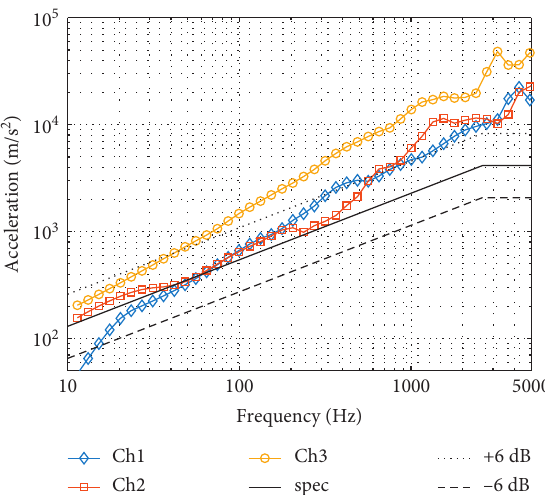
Figure 6: Three-axis test data retrieved from the SRS